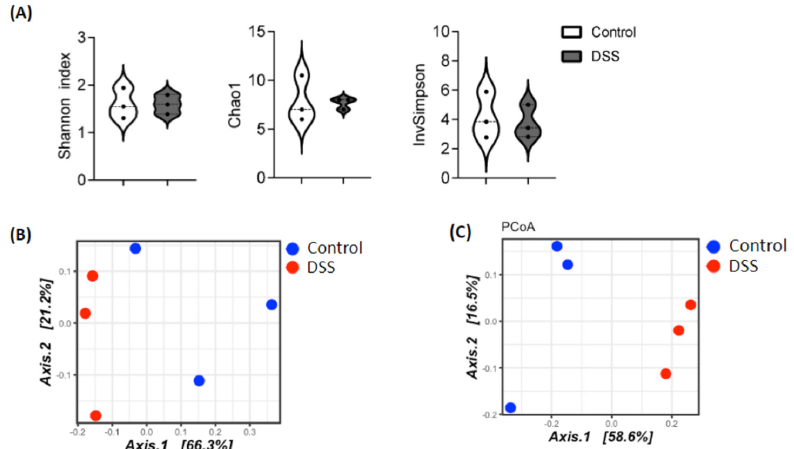
Figure 2. ( A ) Alpha diversity index from 16S rRNA sequencing, ( B ) Principal coordinates analysis (PCoA) plot of the Bray-Curtis dissimilarities of cecal microbiota 16S rRNA profiling Control and DSS treated mice (n = 3/group) at the family ( C ) and genus level.